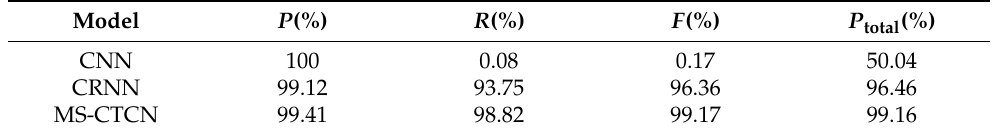
Table 3. Performance of different models.